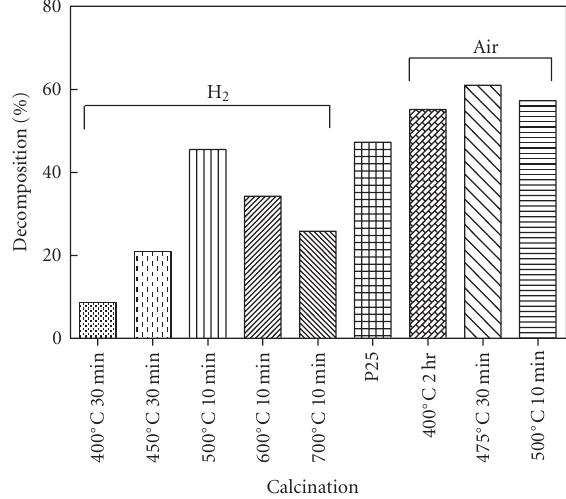
Figure 6: Photocatalytic 4-CP decomposition abilities of the powders with various calcination